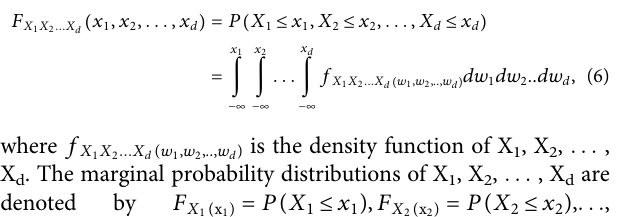
frequently used explanatory variable. A full-parameter model